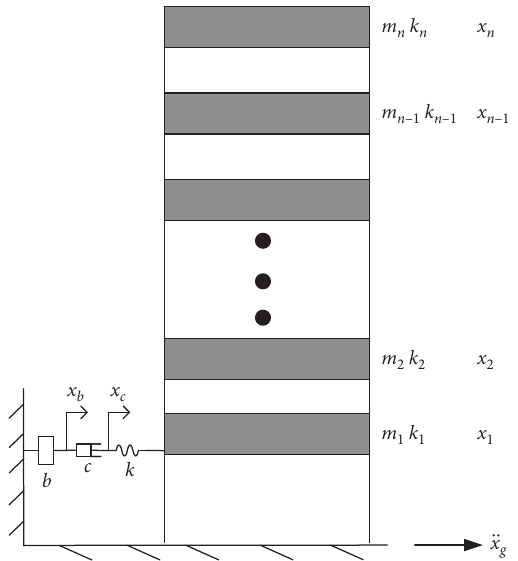
Figure 3: Schematic diagram of structure C3 installed in the multi-degree-of-freedom